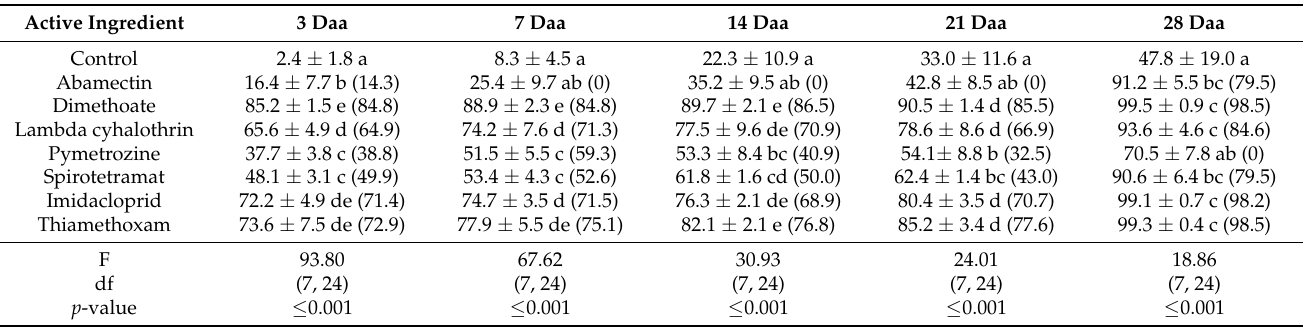
Table 4. Mean percentage of T. erytreae nymph mortality (%) ± standard error at different times (3, 7, 14, 21, and 28 days after application (daa)) in the semi-field trial. In brackets the mean percentages of corrected mortality